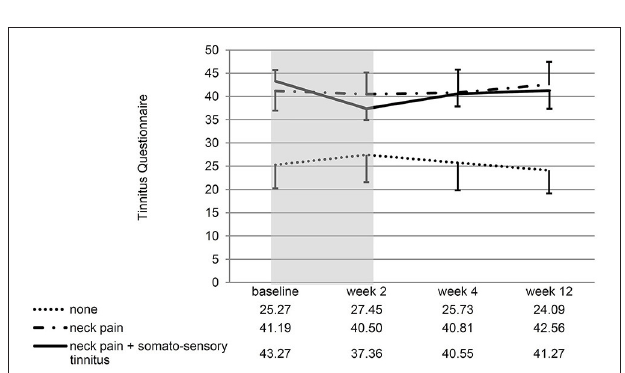
FIGURE 5 | Line chart showing the score at all measurement time points for all three subgroups of patients. Error bars represent standard errors. The 10-day treatment phase is marked in gray color. The TQ change from baseline to week 2 of patients with both somatosensory tinnitus and neck pain differed significantly from the TQ change of patients with neither